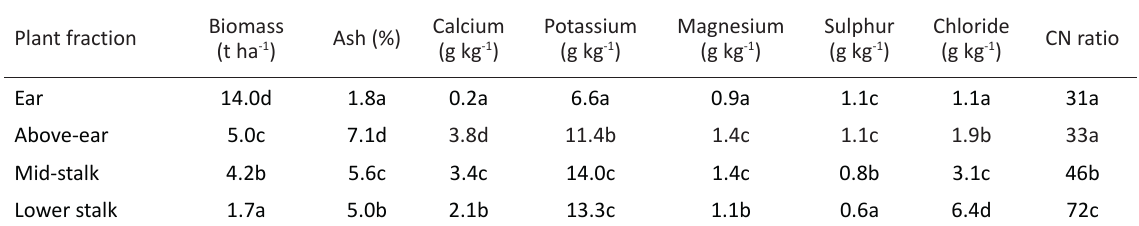
Table 4. Plant portion effect on biomass yield, ash content and mineral element composition of eight maize cultivars showing data of 2010 and 2011 combined Plant fraction